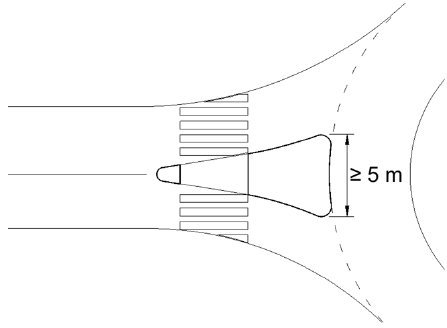
Figure 18. Splitter island according to [15].